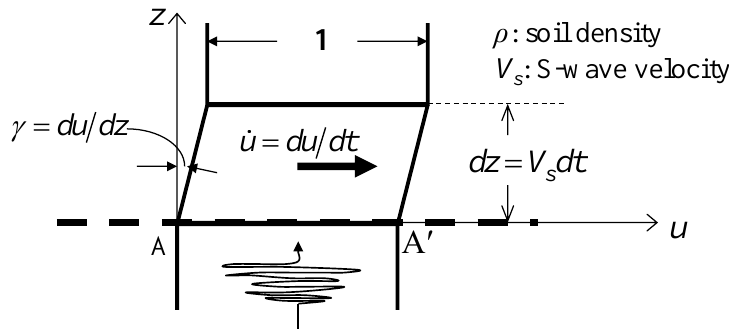
Figure 2. Schematic illustration of wave energy in upward SH wave propagation.